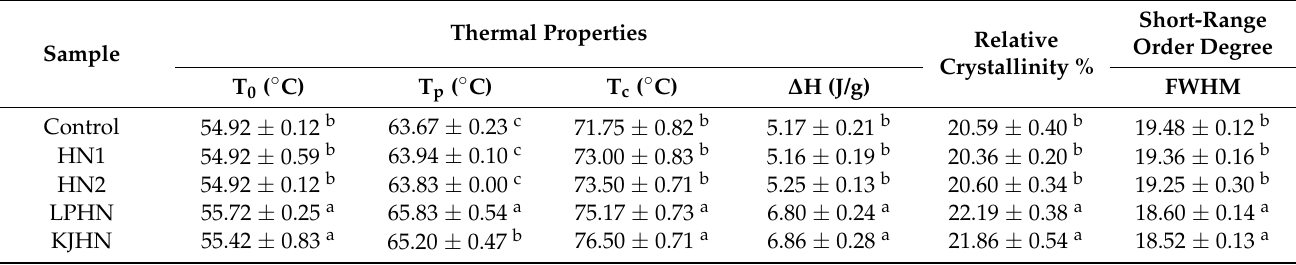
Table 2. Thermal properties, crystallinity and short-range order degree of starch from dried